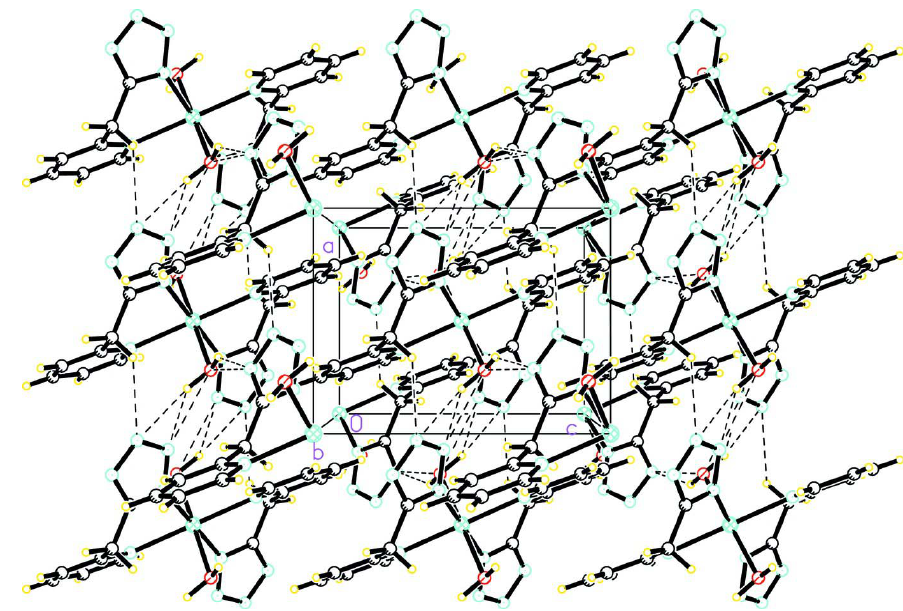
Figure 2 The packing view of title compound with π ··· π stacking along the b